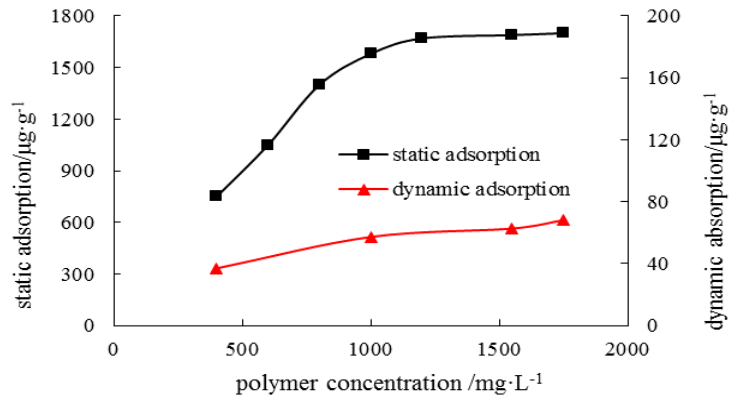
Figure 11. The effect on static adsorption and dynamic adsorption of polymer concentration.